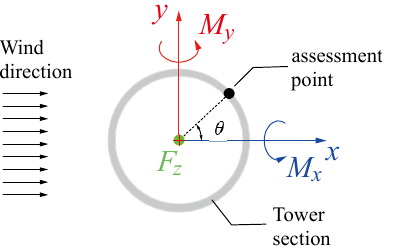
Figure 12. Coordinate system of the fatigue assessment point at the tower base.